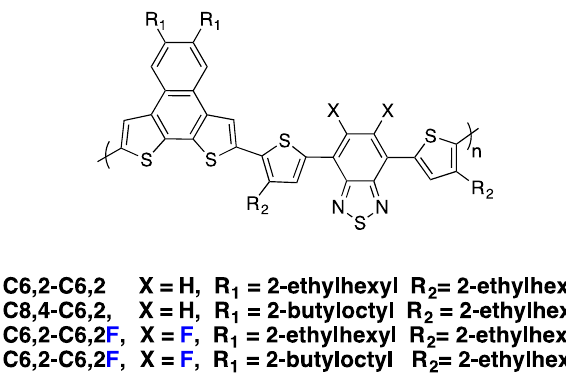
Figure 19. Chemical structures of the investigated polymers [71].